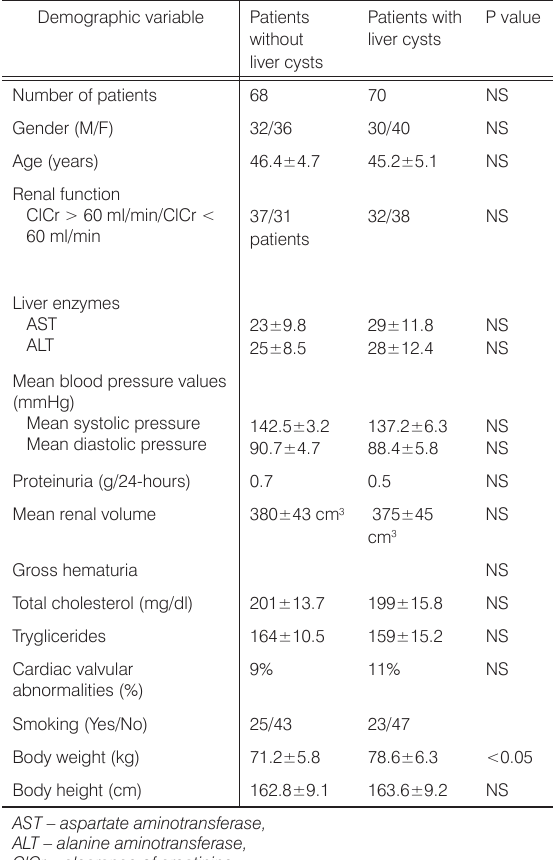
Table 1. Demographic and clinical data of patients